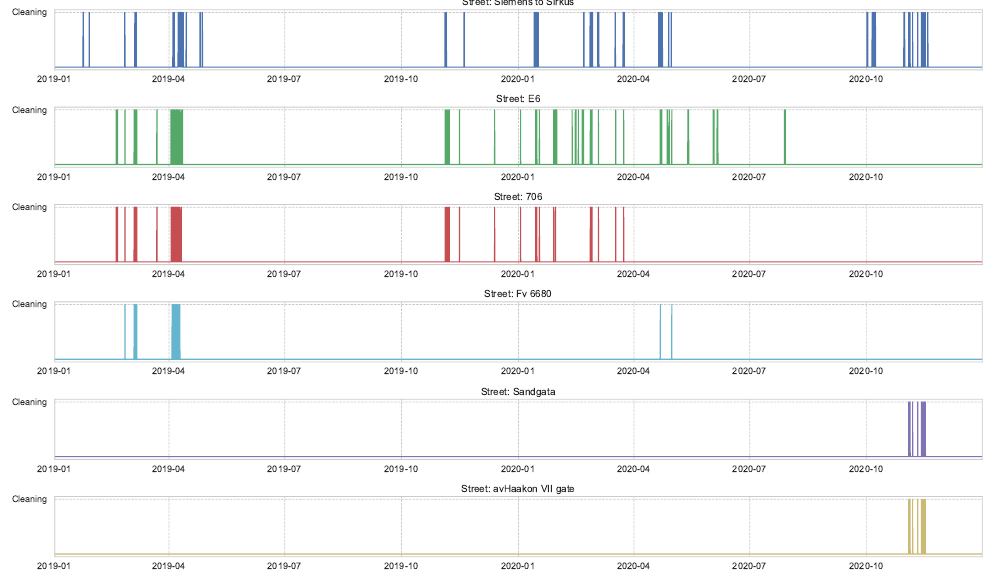
Figure A4. Data of the duration of time in which a street-cleaning is taking place on the main streets of Trondheim, reported by the municipality.